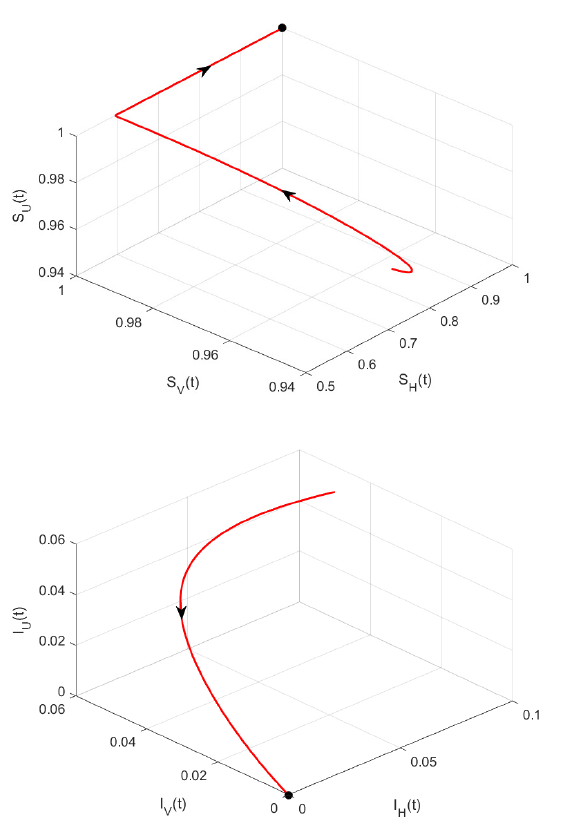
Fig. 6: Phase diagram when R 0 > 1 with parameter values taken to be α 1 = 2 , α 2 = 3 , κ 1 = 0 . 3 , κ 2 = 0 . 2 , ε 1 = 0 . 67 , ε 2 = 0 . 06 , ε 3 = 0 . 06 , µ H = 0 . 00004 , µ V = 0 . 025 , µ U = 0 . 025 , β 1 = 0 . 35 , β 2 = 0 . 8 , λ = 0 . 235 , γ = 0 . 07 , θ 1 = 0 . 33 , θ 2 = 0 . 3